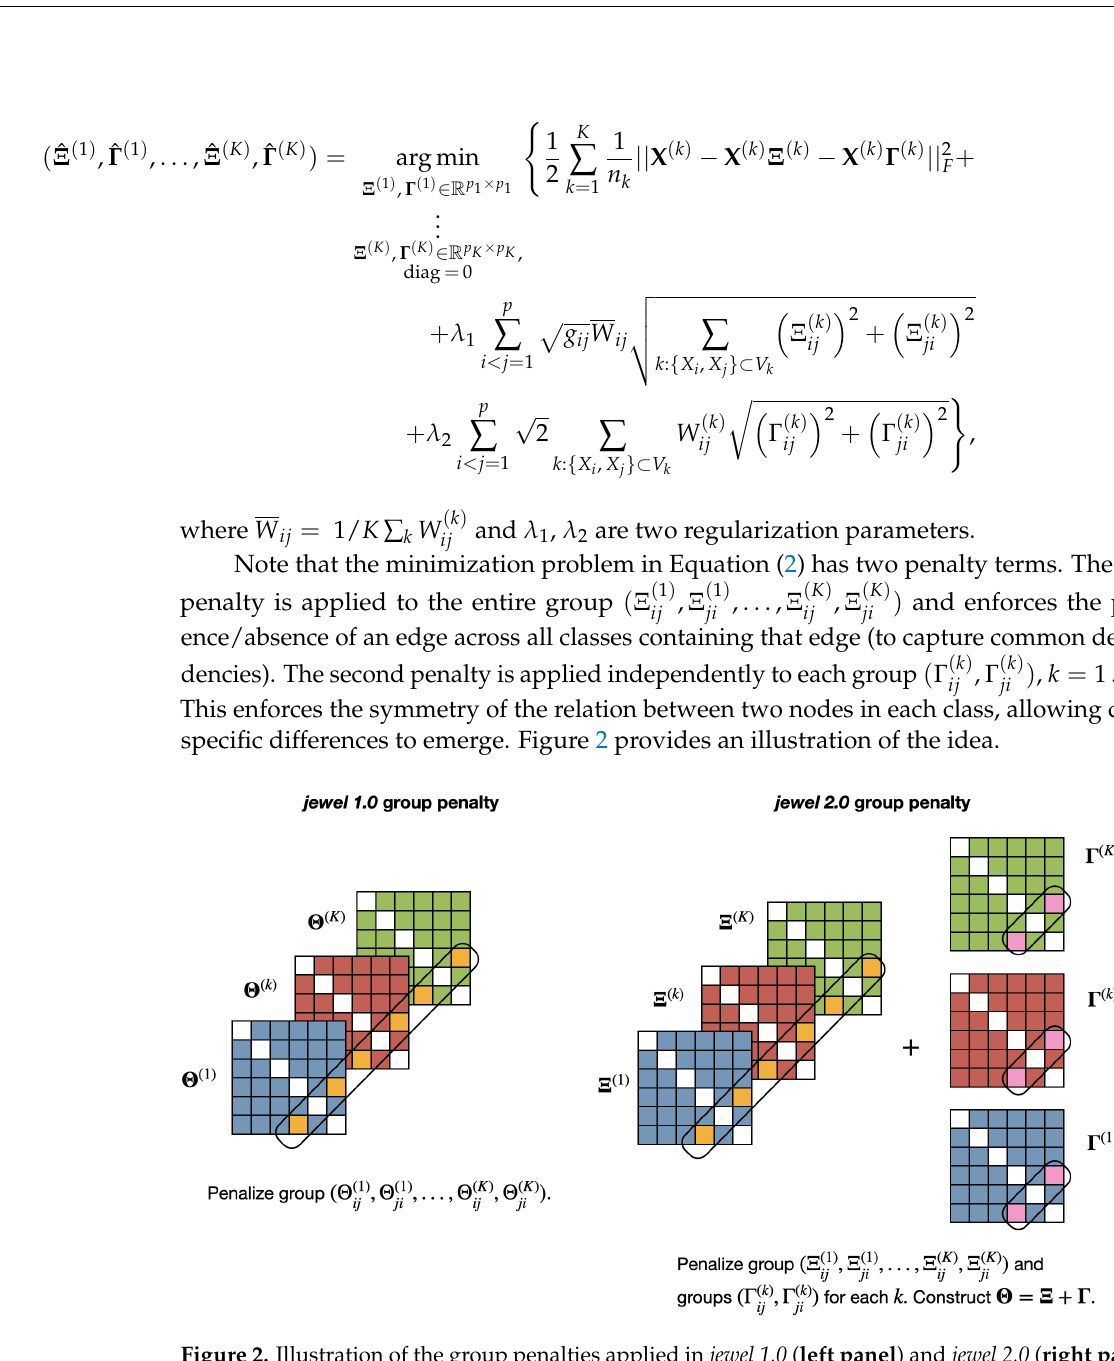
( 1 ) ( 1 ) ( K ) ( K ) ) . In jewel 2.0 , , Θ , . . . , Θ , Θ ij ji ij ji ( 1 ) ( 1 ) ( K ) ( K ) ) . , Ξ , . . . , Ξ , Ξ ij ji ij ji ( k ) ( k ) ) , k = 1 . . . K , independently, allowing , Γ ij ji